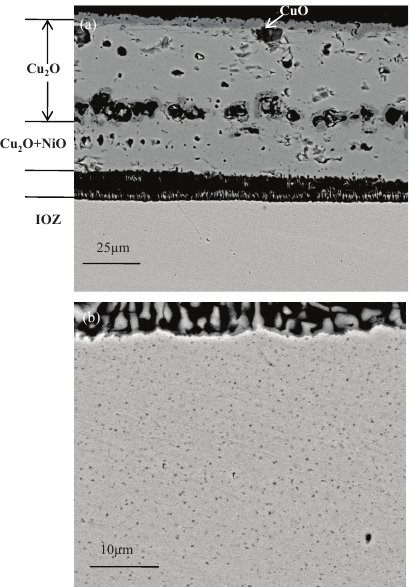
Figure 4. BEI micrographs of a cross section of Cu-1Ni oxidized at 800 °C in 1 atm O 2 for 30 min. (a) General view; (b) Enlarged view of the IOZ.